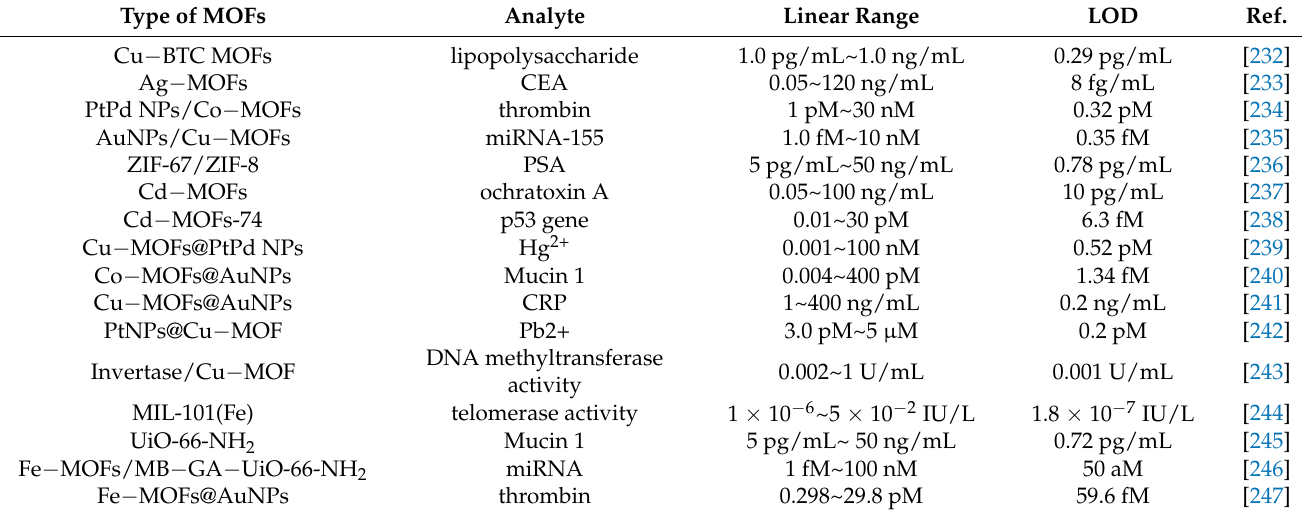
Table 7. Detection performances of different electrochemical sensors by using MOFs as electroactive labels.